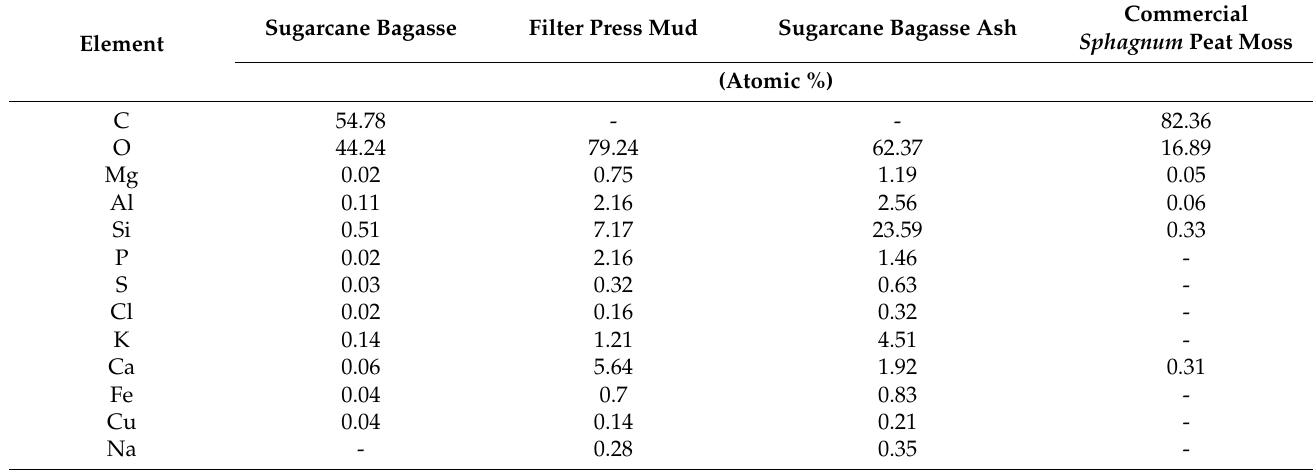
Table 2. SEM/EDS analysis of as-received raw materials and comparison with SPM. Sugarcane Element